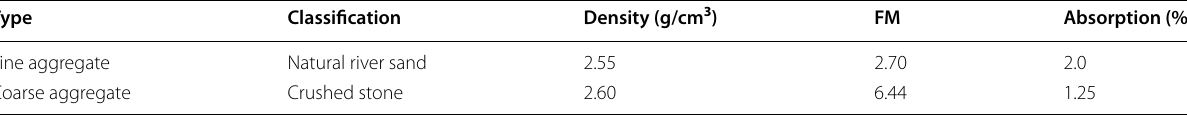
Table 2 Physical properties of aggregates.